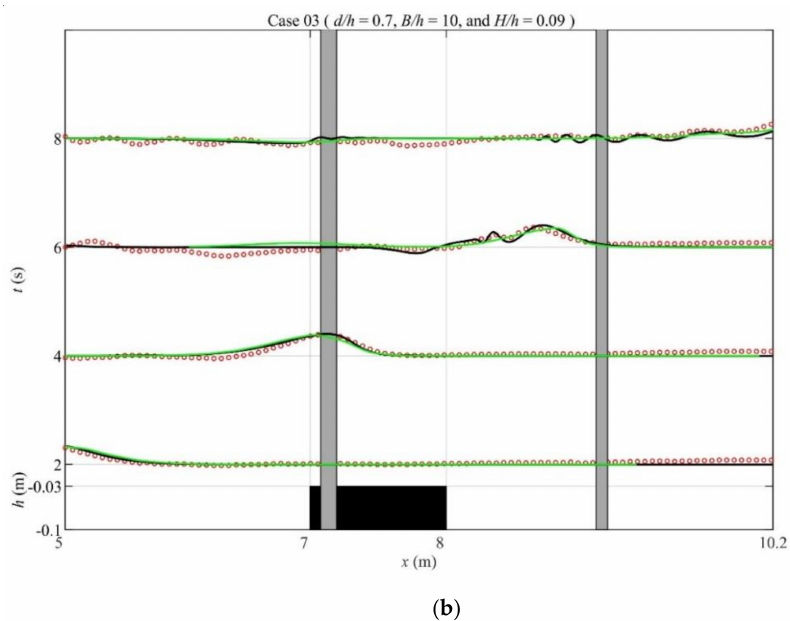
Figure 5. Snapshots of the wave profiles at t = 2, 4, 6, and 8 s (from bottom to top): ( a ) Case 01, d / h of 0.5 and ( b ) Case 03, d / h of 0.7 (circles denote experimental data; black lines denote FD results; grey lines denote FE